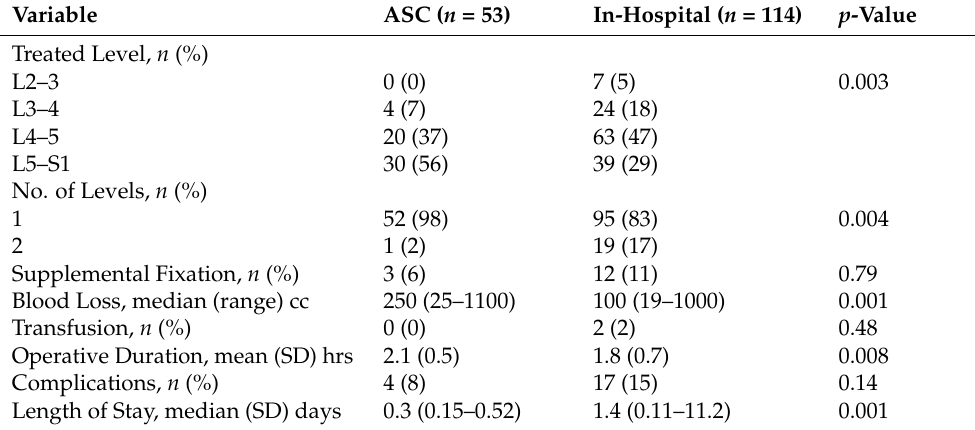
Table 2. Perioperative